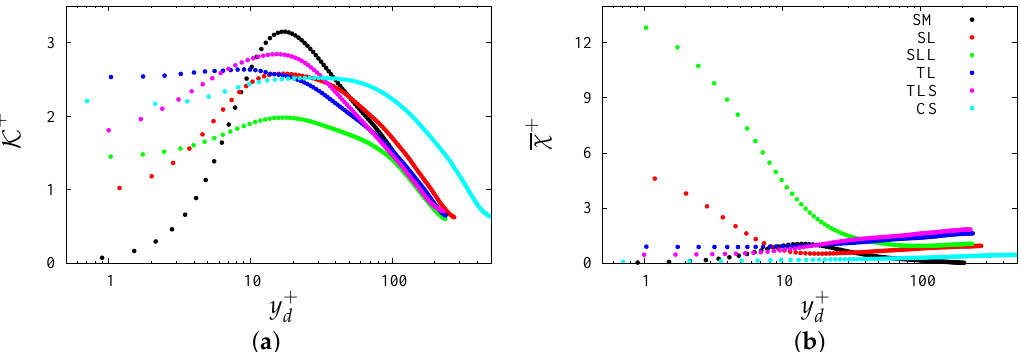
Figure 4. Profiles of ( a ) turbulence kinetic energy ( K ); and ( b ) its coherent contribution ( χ ), for the wall corrugations given in the legend ( Re =